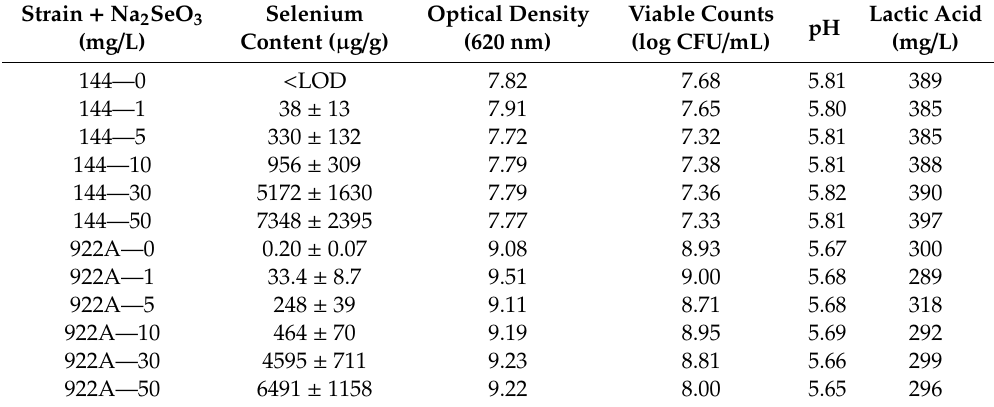
Table 1. Influence of sodium selenite (Na 2 SeO 3 ) concentration on viability, pH, lactic acid production, and selenium binding ability of the CCDM 144 and CCDM 922A